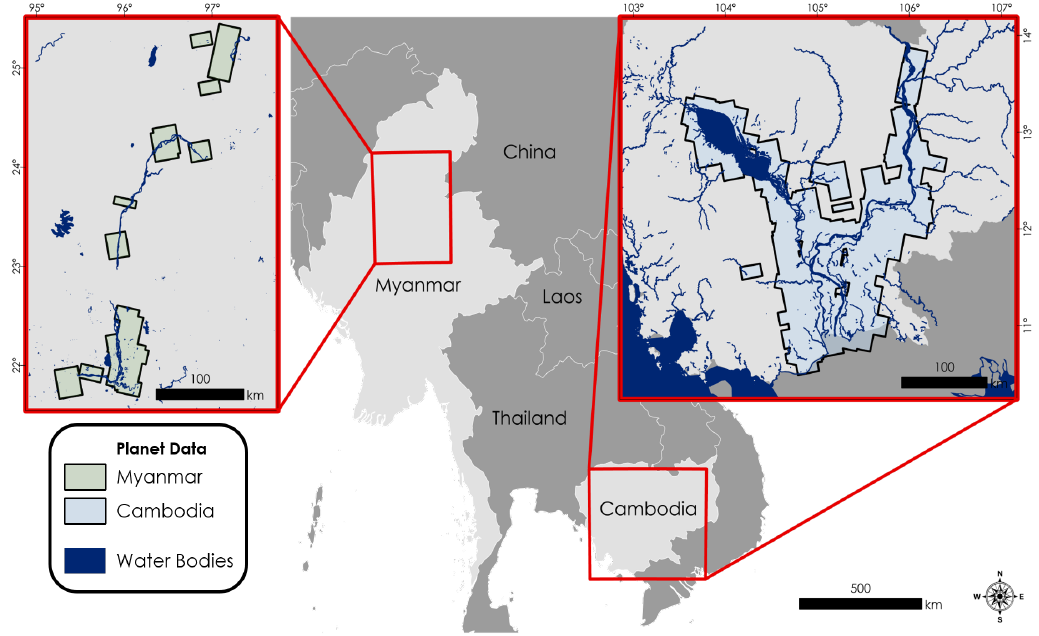
Figure 1. Study Area in Southeast Asia focused on portions of the Upper Irrawaddy river system in North Myanmar and the Tonlé Sap sub-watershed of Cambodia in 2019 during both the wet season and dry seasons. Bounded areas indicate the spatial coverage of Planet Scope Imagery in Myanmar (orange) and Cambodia